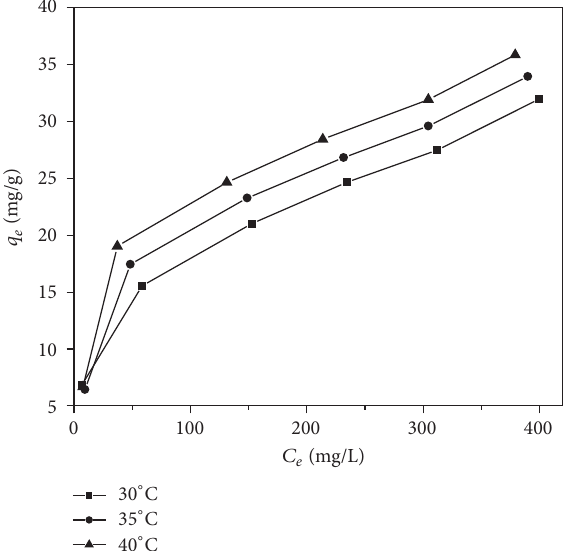
Figure 5: Adsorption isotherms of ammoniacal nitrogen on X/AC composite.